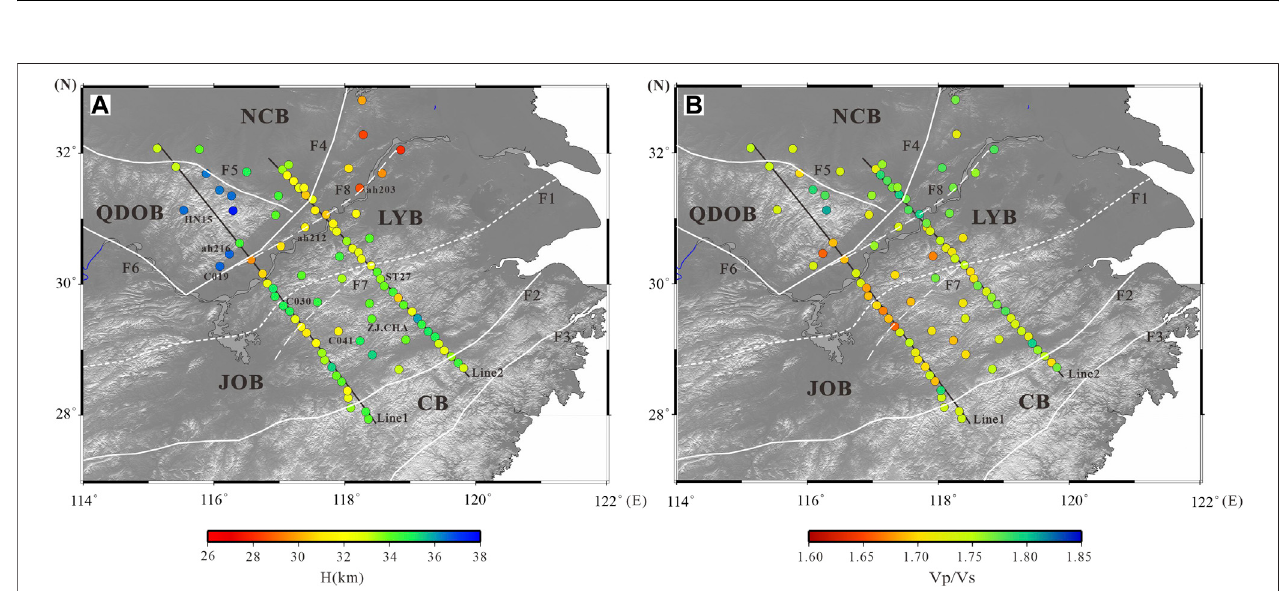
FIGURE 5 | Distribution of crustal thickness (A) and Vp/Vs ratio (B) beneath the stations. Labels are the same as Figure 1 .